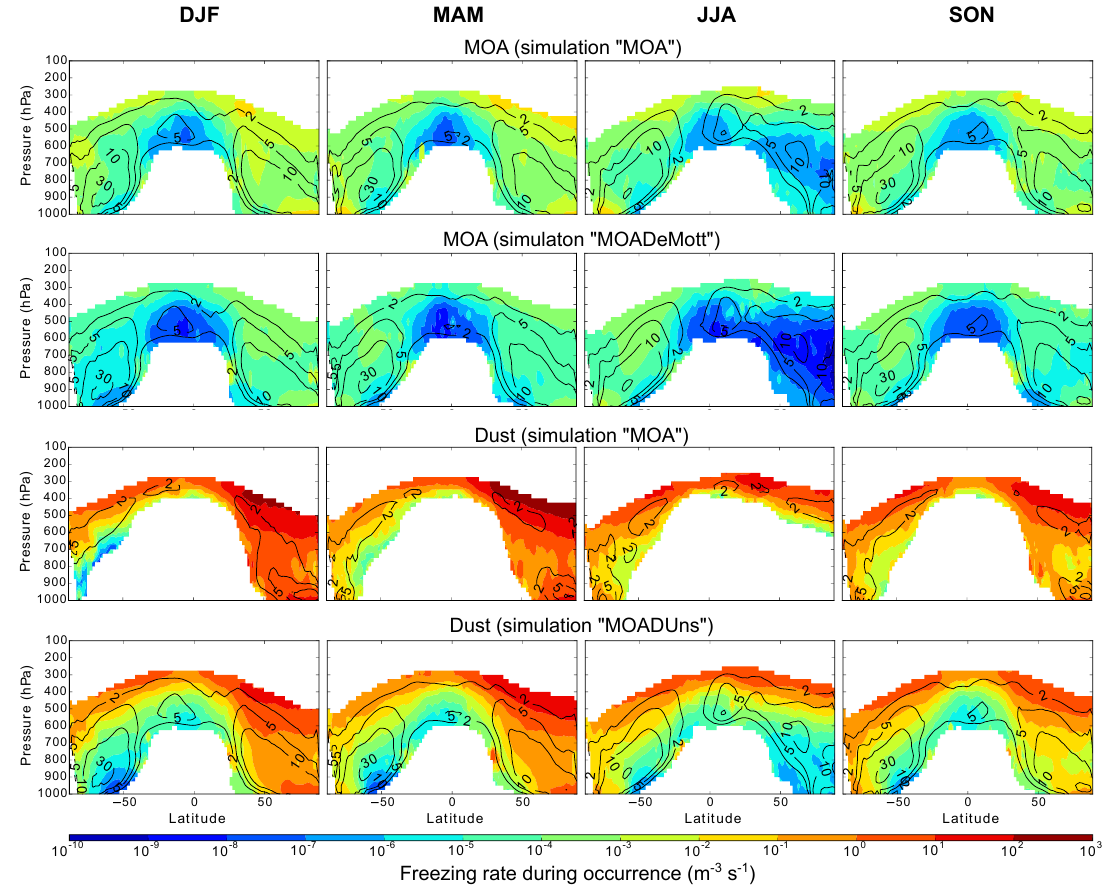
Figure 5. Seasonal and zonal mean freezing rates due to MOA and dust aerosol during freezing occurrence. Contour lines denote the frequency with which freezing occurs in %. All plots are averages from the 10-year free-running simulations. Only rates where the freezing occurs more often than 0.1% of the time are